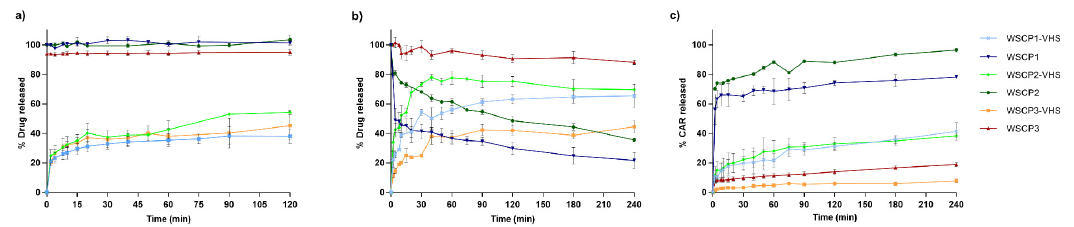
Figure 6. Amount of released WSCP1-3 at pH ( a ) 1.2 and ( b ) 6.8. Amount of carvacrol (CAR) released from WSCP1–3 and WSCP1–3 adsorbed–VHS hybrids at pH 6.8 ( c ). Each experiment was repeated three times and error bars represent the standard deviation.